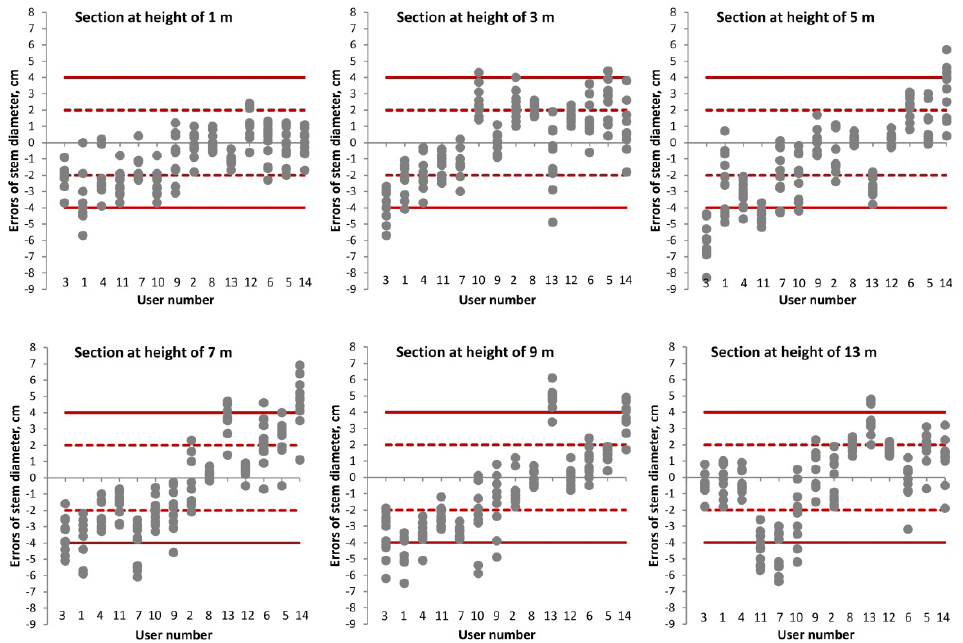
Figure 2. Errors variation in stem diameter measurement using a laser caliper depending on section height and users. The red lines enclose the values with the error range of ±4 cm in relation to the true diameters and the red dashed lines enclose the values with the error range of ±2 cm in relation to the true diameters.